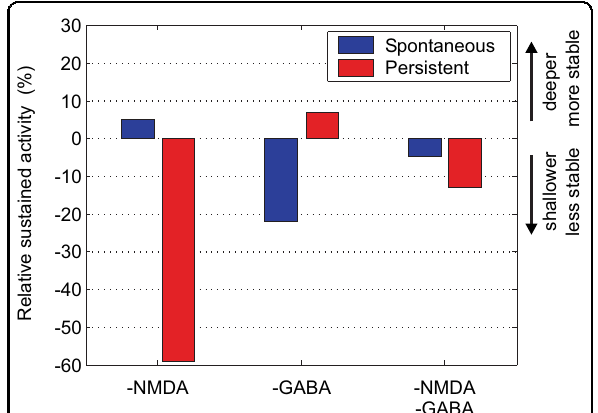
Fig. 3 Stability of the spontaneous low fi ring rate and persistent high fi ring rate states of the short-term memory in the integrate- and- fi re attractor network of Fig. 2. The percentage of trials in which the average activity during the last second (2 – 3 s) remained in the reference state is shown. Decreasing the NMDA conductances by 4.5% (NMDA: − 1) decreased the stability of the high- fi ring rate (Persistent) state, in that the fi ring often failed to be maintained in the high fi ring rate short-term memory state. Decreasing the GABA conductances by 9% decreased the stability of the Spontaneous fi ring rate state, with the system frequently jumping into a high fi ring rate state. Decreasing both the NMDA and the GABA conductances decreased the stability of the high fi ring rate short-term memory state (labeled persistent), which frequently fell out into low fi ring. Decreasing both the NMDA and the GABA conductances in addition decreased the stability of the Spontaneous state, which sometimes jumped into a high fi ring rate state. The condition of decreased NMDA and GABA is how we characterize schizophrenia, in that stability of attention, memory, and thought processes implemented by high fi ring rate states are reduced as applies to the cognitive symptoms; and in that the system often jumps from the spontaneous low fi ring rate state in which there is no retrieval cue into a high fi ring rate state, modeling the positive symptoms with intrusive thoughts, delusions, and hallucinations. Shallower basins of attraction relate to less stability. (Modi fi ed from Loh et al. 7